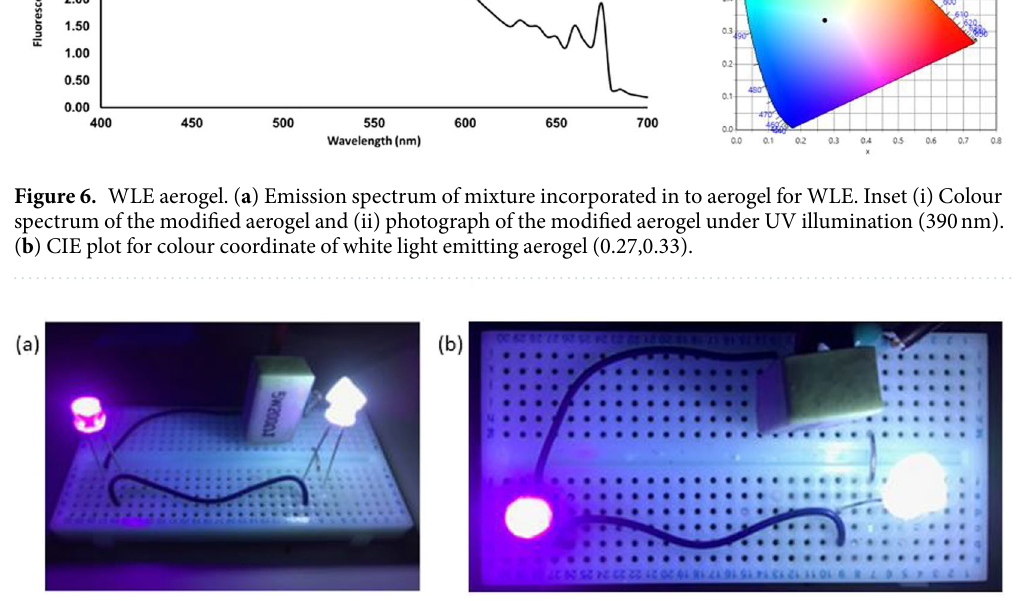
Figure 7. Side-by-side image for the same UV LED. In each image the left hand side is the uncoated UV LED and the right hand side LED is coated with aerogel to produce WLE. Both images are taken of the same experimental setup: ( a ) is a side view and ( b ) is a top